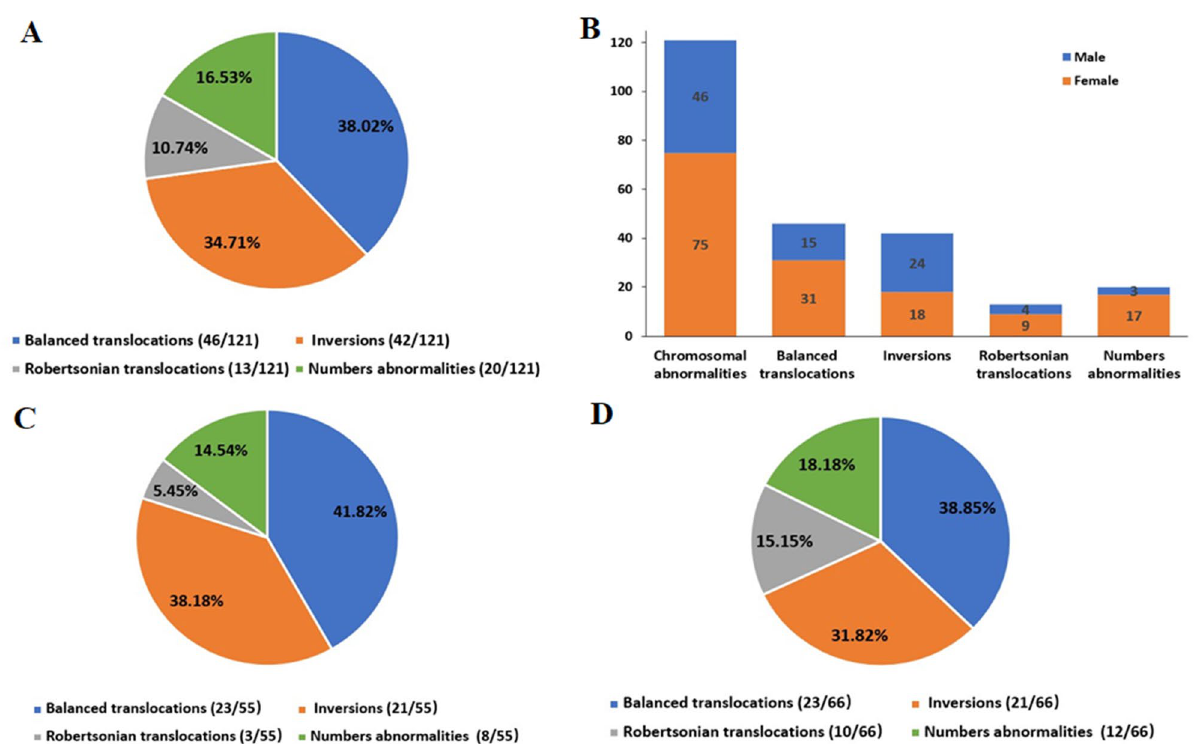
Figure 2. ( A ) The distribution of four aberrant types in the 121 RPL couples. ( B ) The respective numbers of female and male in the four aberrant type couples. ( C ) and ( D ). The distribution of four aberrant types in the 55 pregnancy and 66 non-pregnancy